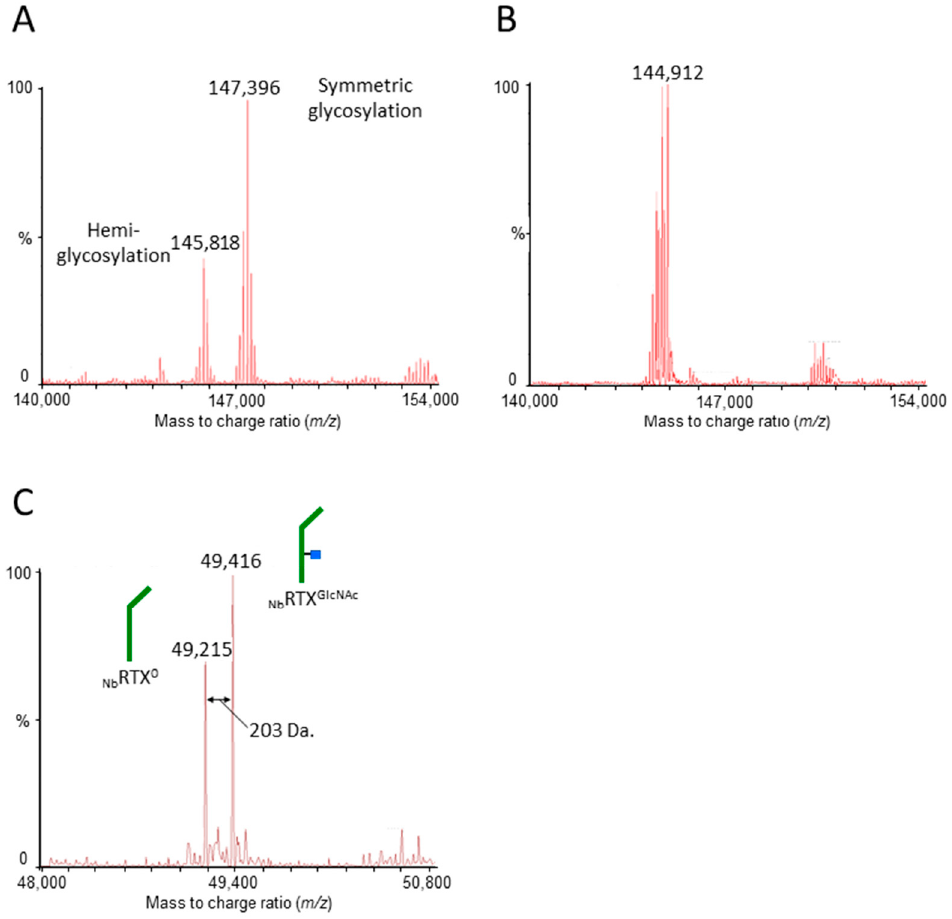
Figure 2. Nano liquid chromatography-electrospray ionization-quadrupole time of flight-mass spectrometry (NanoLC-QTOF-MS) analysis of plant-made rituximab. ( A ) Deconvoluted electrospray ionization (ESI)-mass spectrum of purified Nb RTX analyzed under non-reducing conditions showing fully glycosylated and hemiglycosylated rituximab; ( B ) Deconvoluted ESI-mass spectrum of